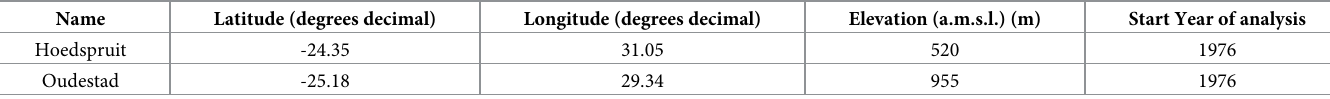
Table 1. Summary of temperature stations with location and